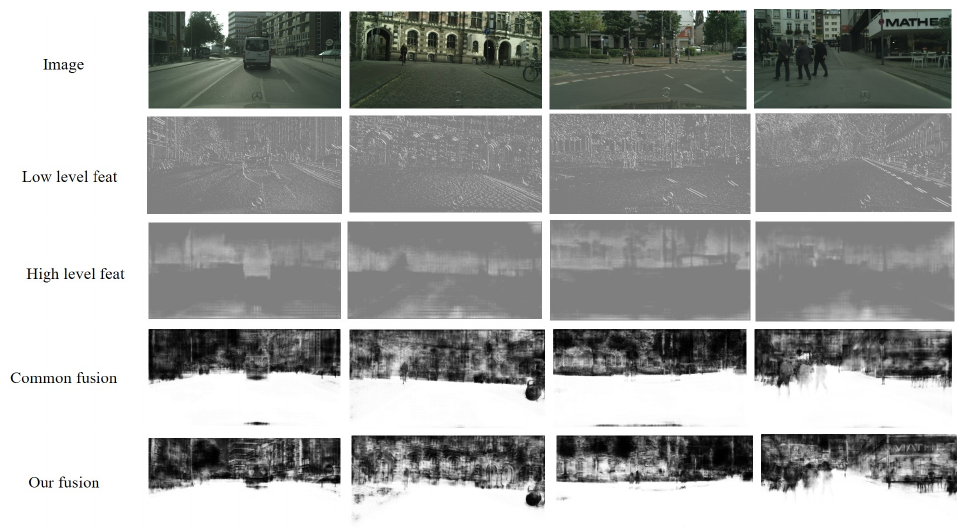
Figure 5. Visualization results of inter-level feature balanced fusion compared to common fusion on the Cityscapes set. For each line, we show an input image, and feature mapping from two levels. Meanwhile, we show the visualization of general fusion of two hierarchical features and visualization of fusion results using inter-level feature balanced fusion